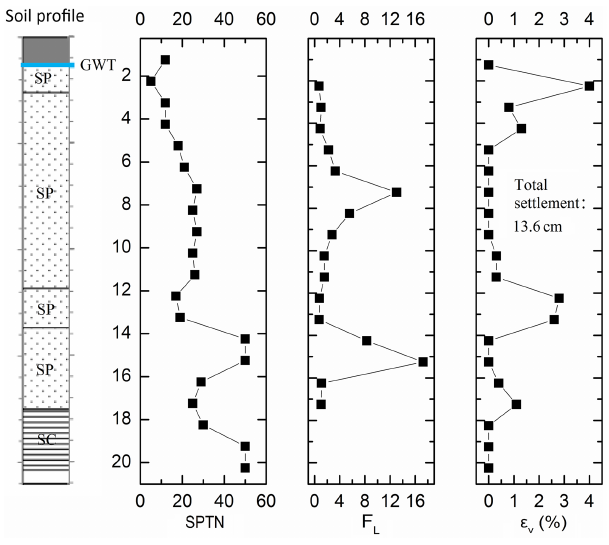
Figure 8. Soil profile and estimate of